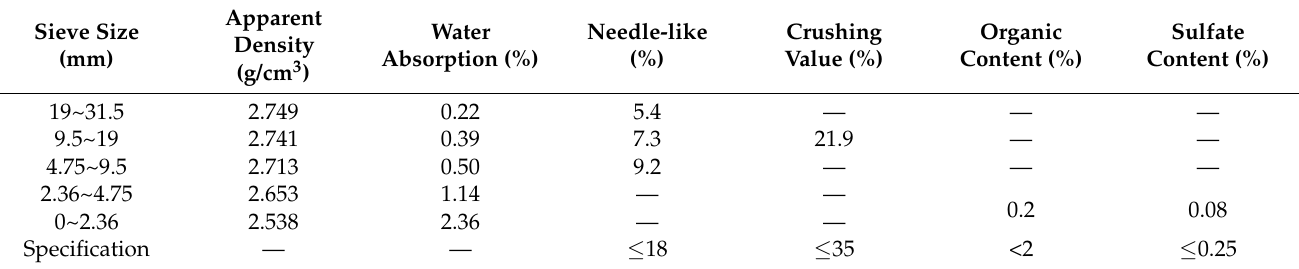
Table 3. Basic properties of limestone aggregates.